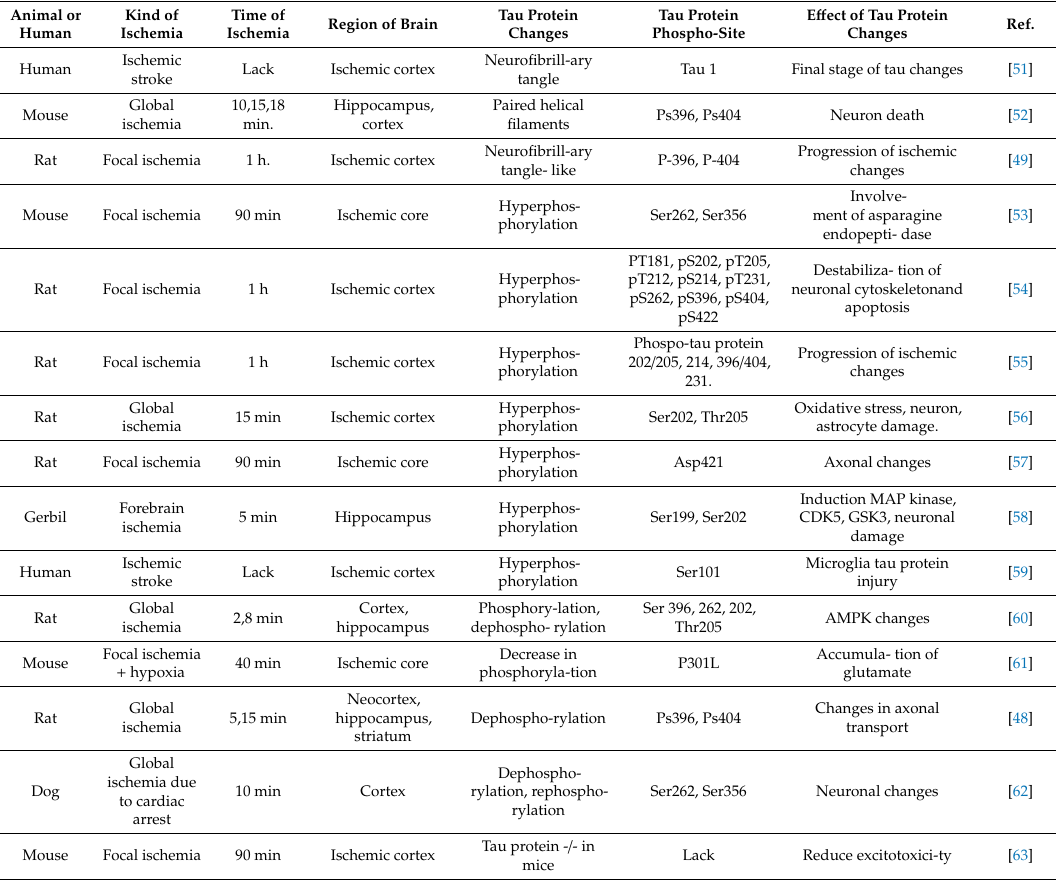
Tau Protein Tau Protein E ff ect of Tau Protein Changes Phospho-Site Changes